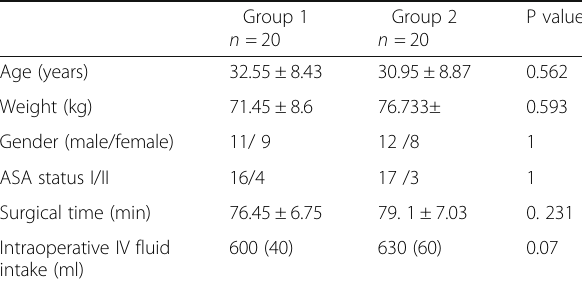
Table 1 Demographic data